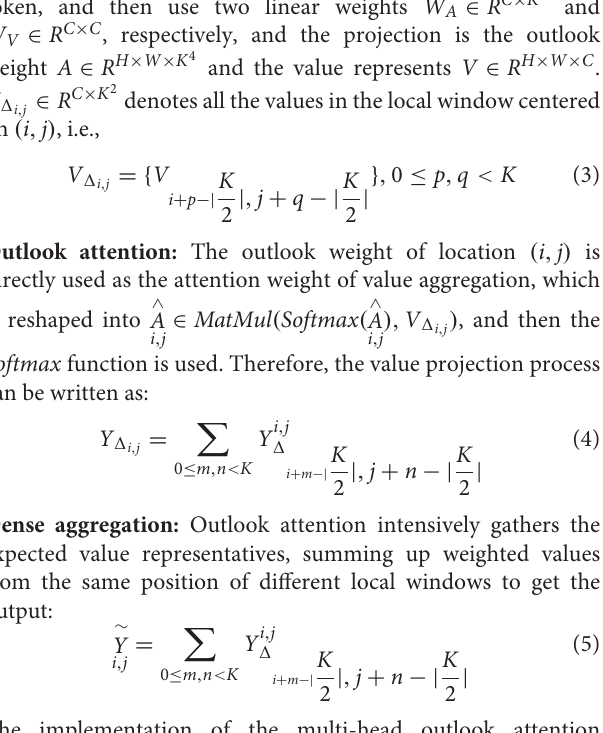
Bold highlights the specific method used in the